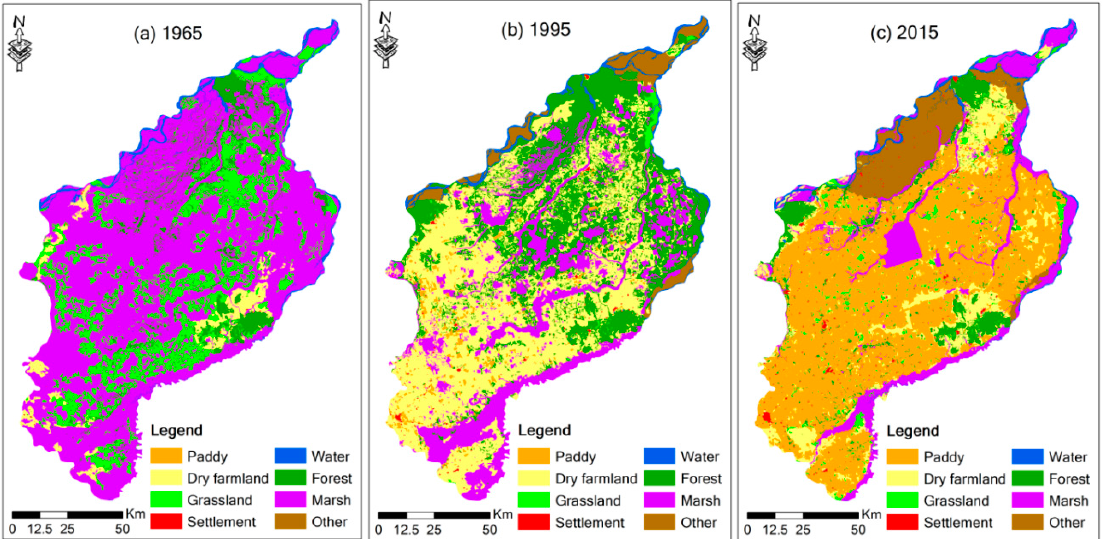
Figure 4. The spatial changes of land-use distribution in the SSP during 1965–2015.